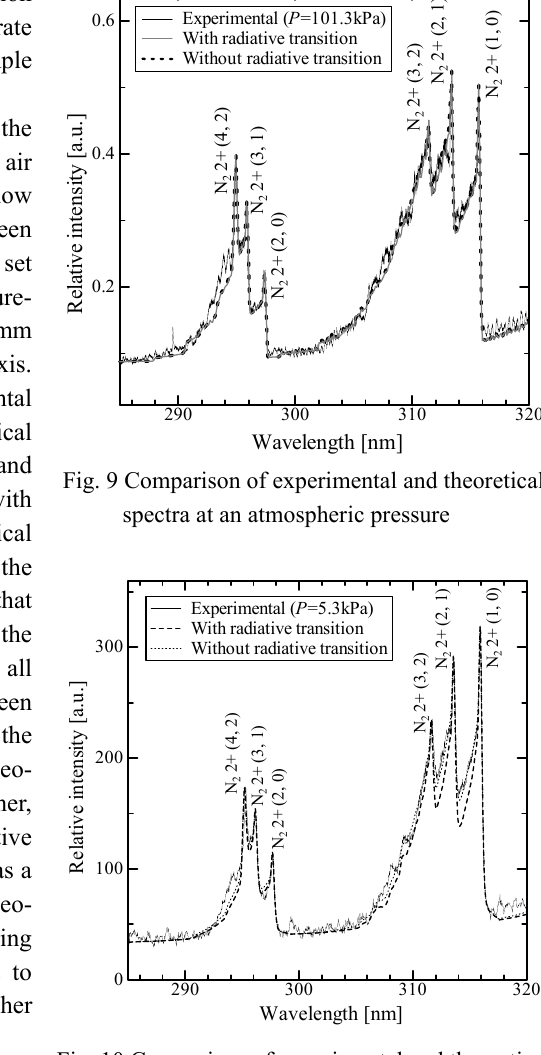
Fig. 10 Comparison of experimental and theoretical spectra at low